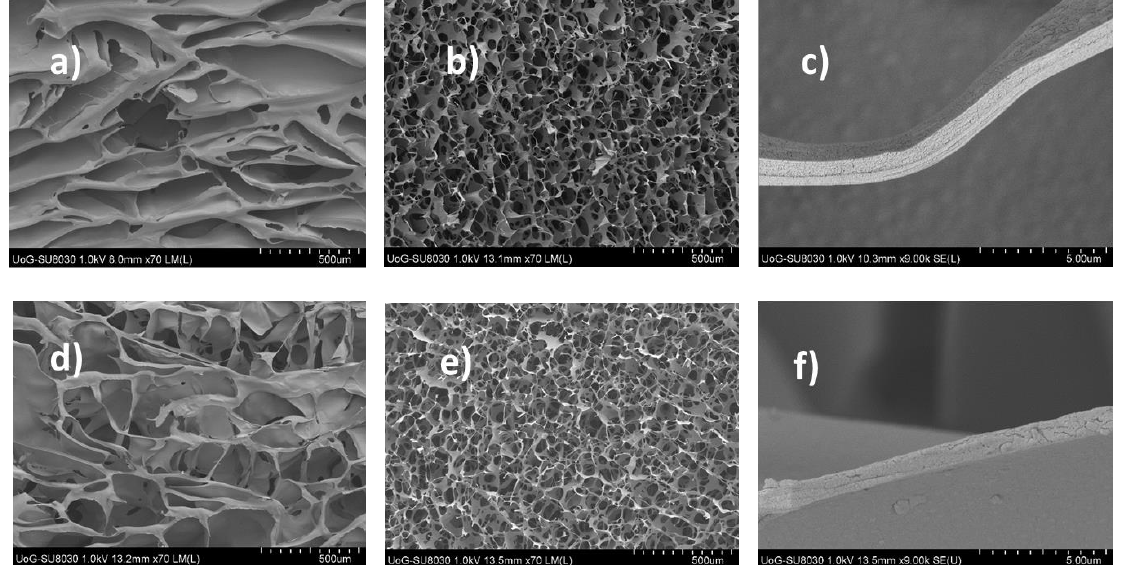
Figure 3. Shows representative topographical images of blank composite SA#:FCOL:HA 1:2:5 scaf- folds: ( a – c ) top, bottom, and wall thickness respectively showing sheet-like structures with a mean pore size of 440 µm (top) and 107µm (bottom) of the scaffold and wall thickness ranging from 0.442 to 1.864 µm; and ( d – f ) SA*:FCOL:HA scaffolds showing interconnected honeycomb-shaped pores with a mean pore size of 282 µm (top) and 127 µm (bottom) and a wall thickness ranging from 0.485 to 0.939 µm.